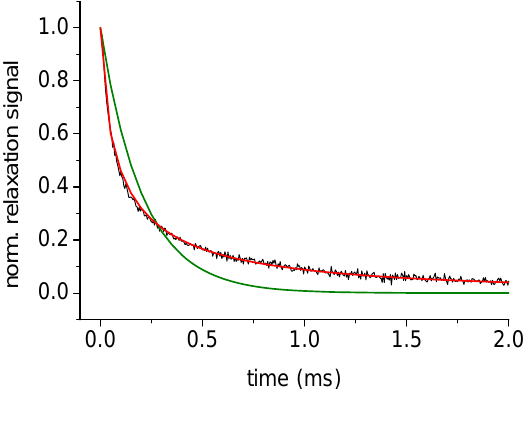
Figure 2. Normalized relaxation data of DDM128N particles of 55 nm in diameter (black) fitted with monoexponential decay (green) and size distribution function